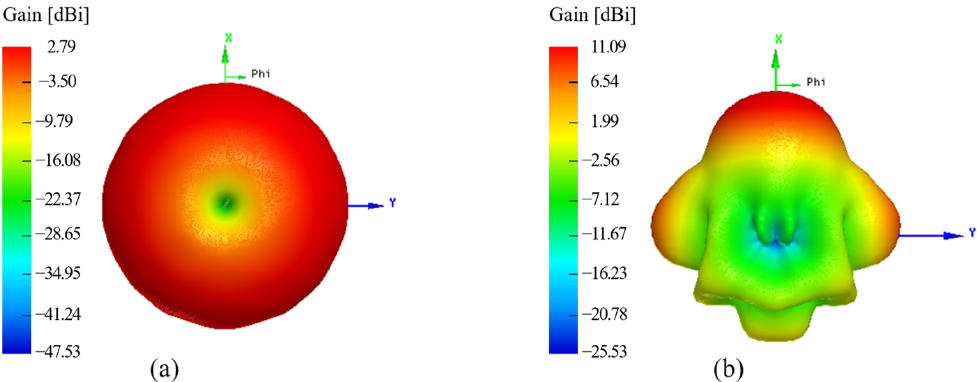
Figure 5. Comparative numerical results for the gain ( a ) of the dipole antenna and ( b ) the antenna with the quasi-cylindrical Bragg